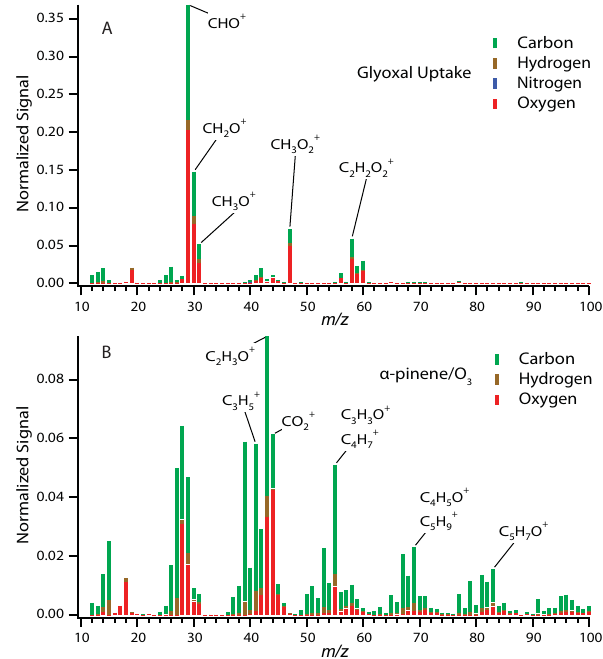
Fig. 2. High-resolution mass spectra of glyoxal (A) and α -pinene (B) SOA with elemental contributions to each mass-to-charge ratio shown. Spectra are taken at the peak of SOA